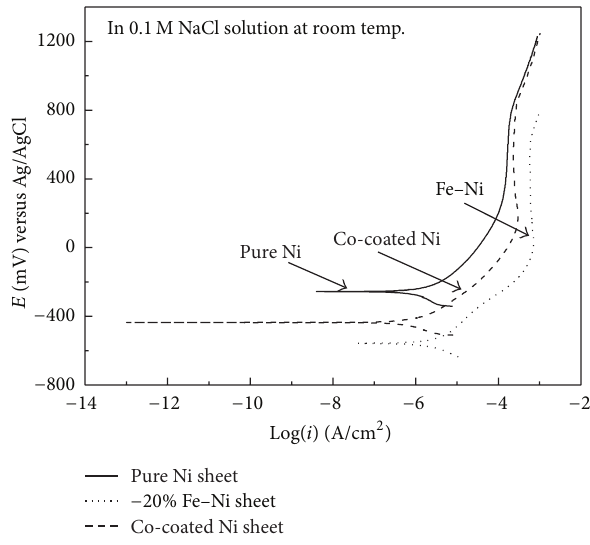
Figure 1: Potentiodynamic polarization response of the alloys in 0.1M NaCl solution at room